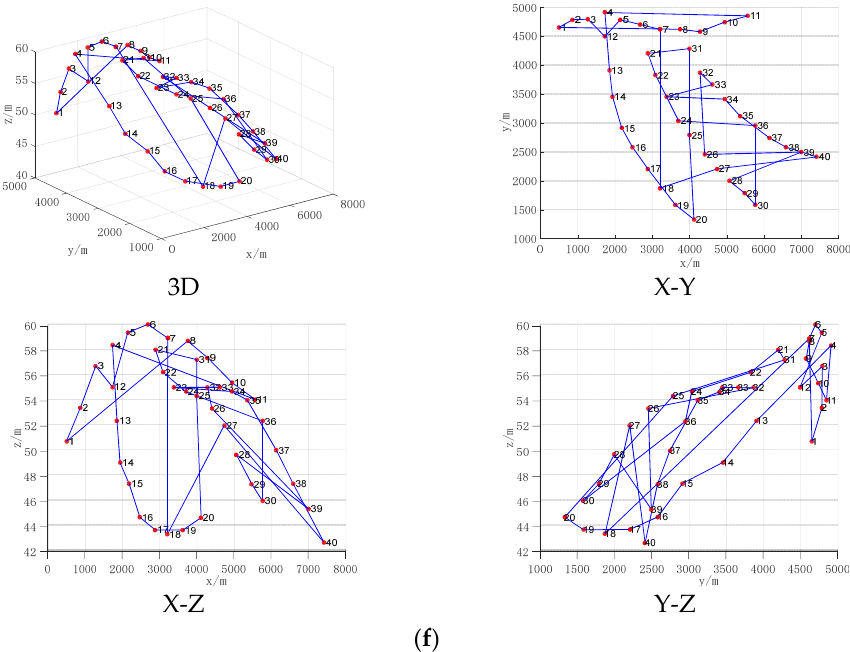
Figure 11. ( a ) Optimal energy consumption operation path at load 0 g; ( b ) Optimal energy consumption operation path at 100 g load; ( c ) Optimal energy consumption operation path at 200 g load; ( d ) Optimal energy consumption operation path at 300 g load; ( e ) Optimal energy consumption operation path at 400 g load; ( f ) Optimal energy consumption operation path at 500 g load.